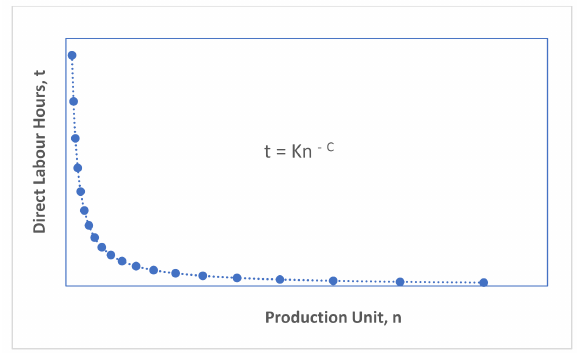
Figure 13. Generalrelationship, component cost and production